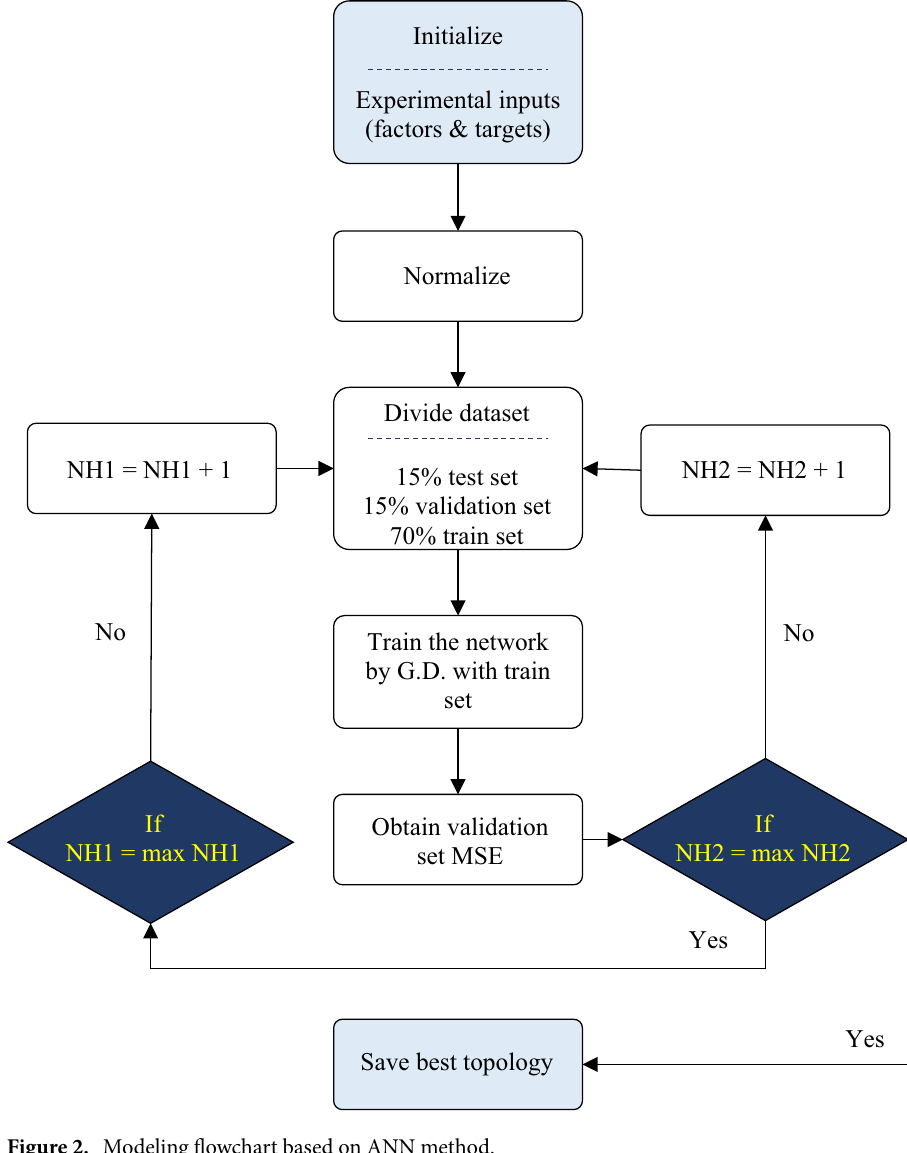
Figure 2. Modeling flowchart based on ANN